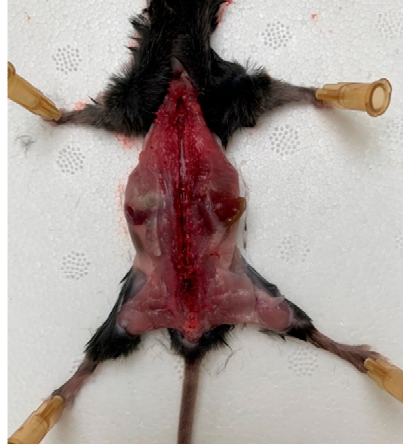
Figure 1. A mouse on the operating table with the limbs maximally distant from the body, the spinal column released from the muscle, and connective tissues and spinal canal opened.